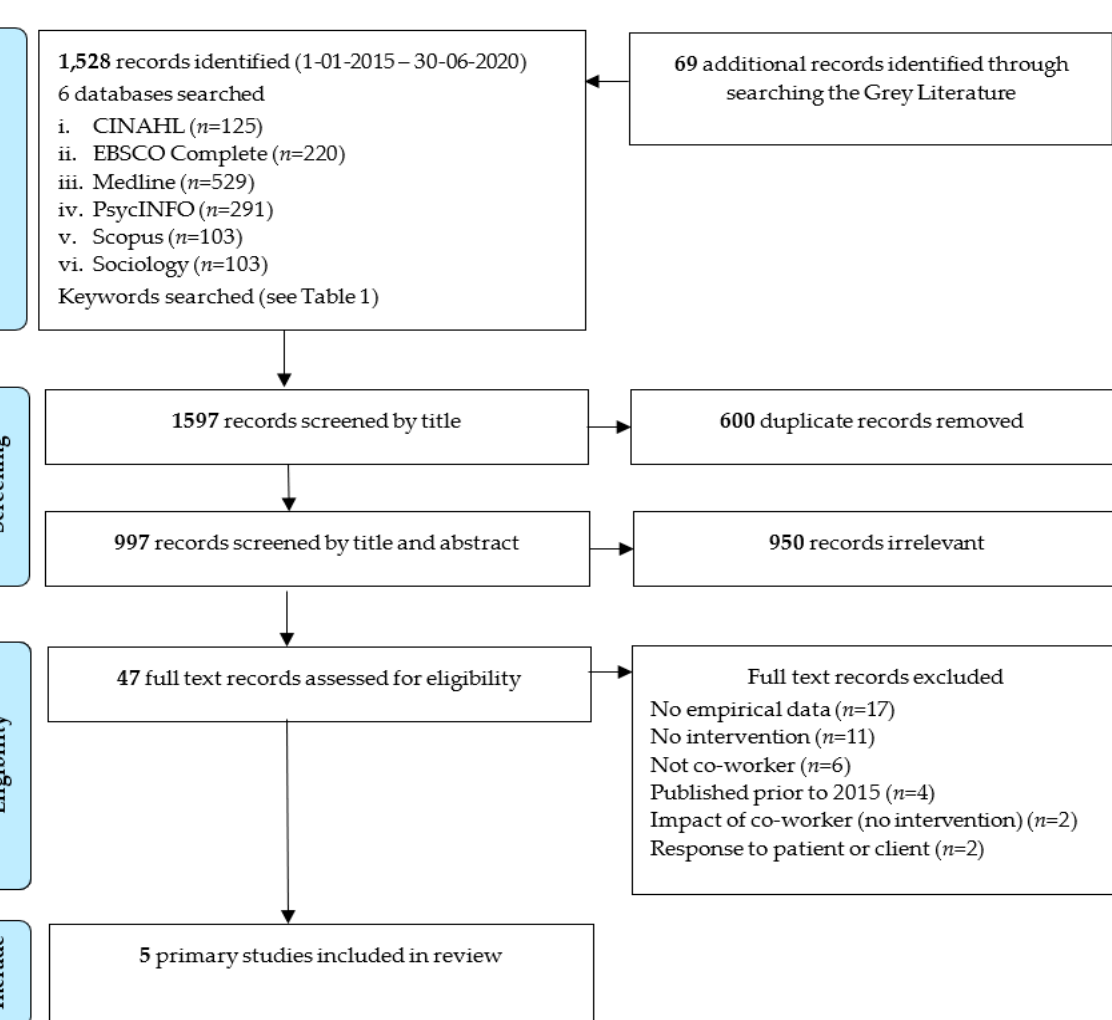
Figure 1. PRISMA flowchart diagram.